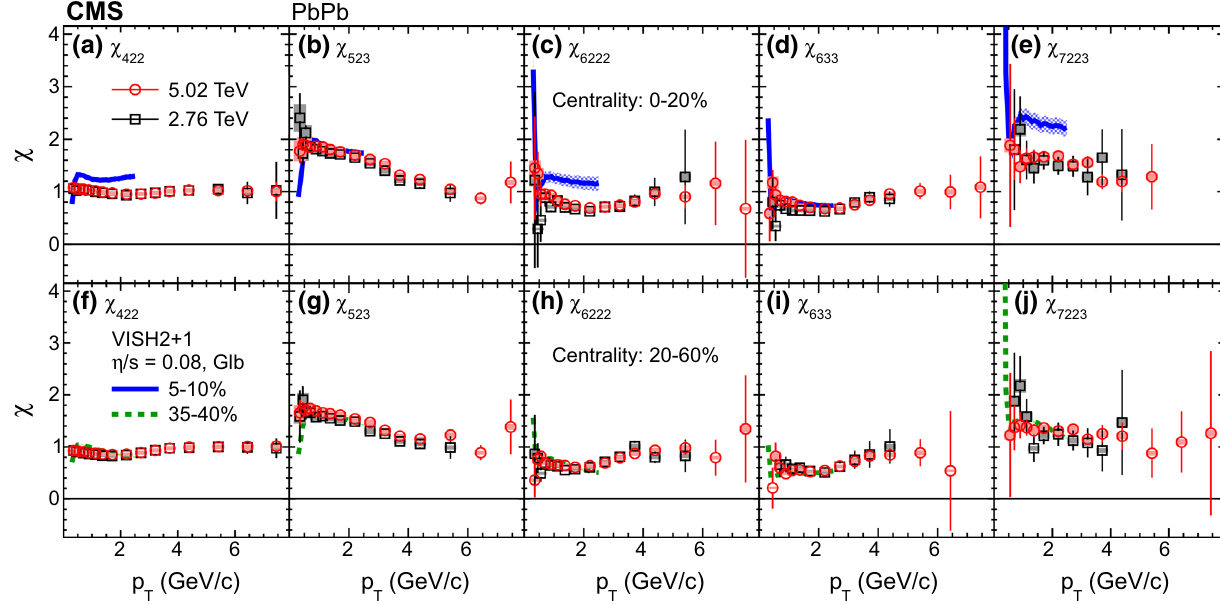
Fig. 3 Nonlinear response coefficients, χ 422 , χ 523 , χ 6222 , χ 633 , and χ 7223 from the scalar-product method at as a function of p T in the 0–20% (upper row) and 20–60% (lower row) centrality ranges. Statistical (bars) and systematic (shaded boxes)